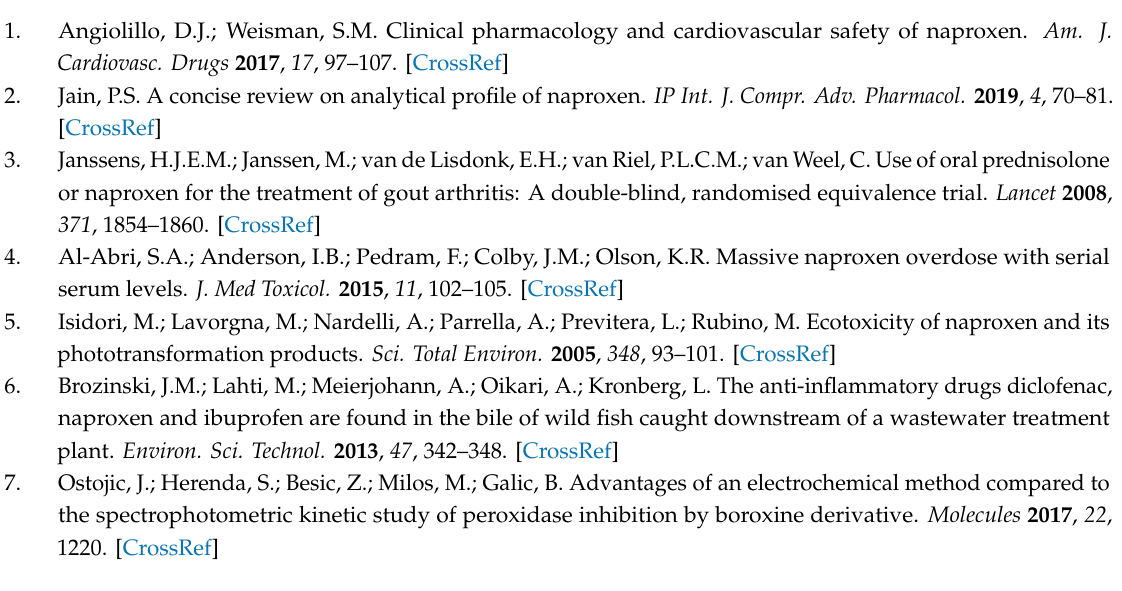
Figure S1. High-resolution XPS spectra of: (A) F1s peak of fluorinated graphene oxide at 692.675; (B) N1s peak of nitrogen doped reduced graphene oxide at 400.137 eV; and (C) B1s peak of boron doped reduced graphene oxide at 197.455 eV. Figure S2: High-resolution C1s spectra with deconvoluted peaks for N-rGO. Figure S3: High-resolution C1s spectra with deconvoluted peaks for B-rGO. Figure S4: High-resolution C1s spectra with deconvoluted peaks for F-GO. Figure S5: CV curves of GO / GCE recorded at a scan rate of 50 mV / s in 0.1M PBS (pH 7.2) bu ff er in the absence of (dashed line) and in the presence of 300 µ M Naproxen (solid line). Figure S6. DPV curves of the various electrodes recorded in a solution 0.1M PBS (pH 7.2) containing 300 µ M of